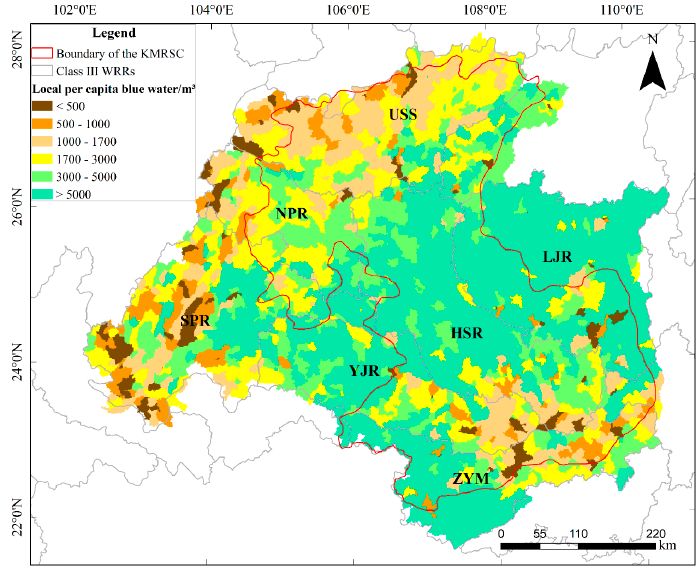
Figure 15. Spatial distribution of local per capita blue water in the modelling domain. There existed many regions with small local per capita blue water resource of less than 1700 m 3